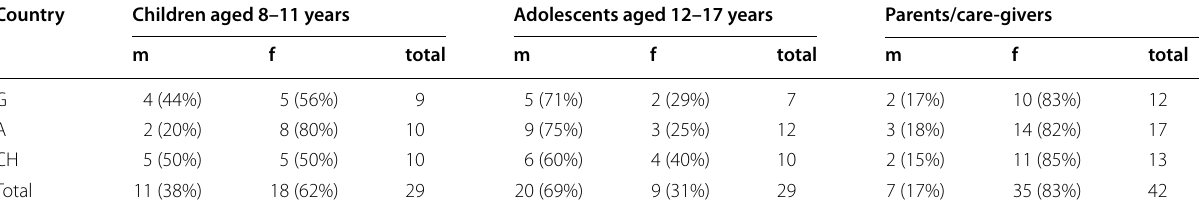
M , male, f , female, G , Germany, A , Austria, CH , Switzerland